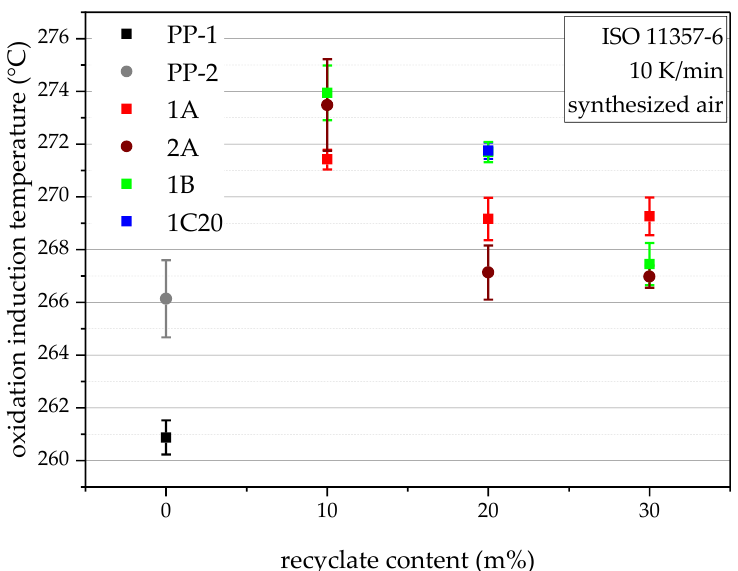
Figure 7. Graphical illustration of oxidation induction temperatures of the virgin blending partners PP-1 and PP-2 (as 0 m% recyclate content data points), and all compounds. The vertical bars show the sample standard deviations.